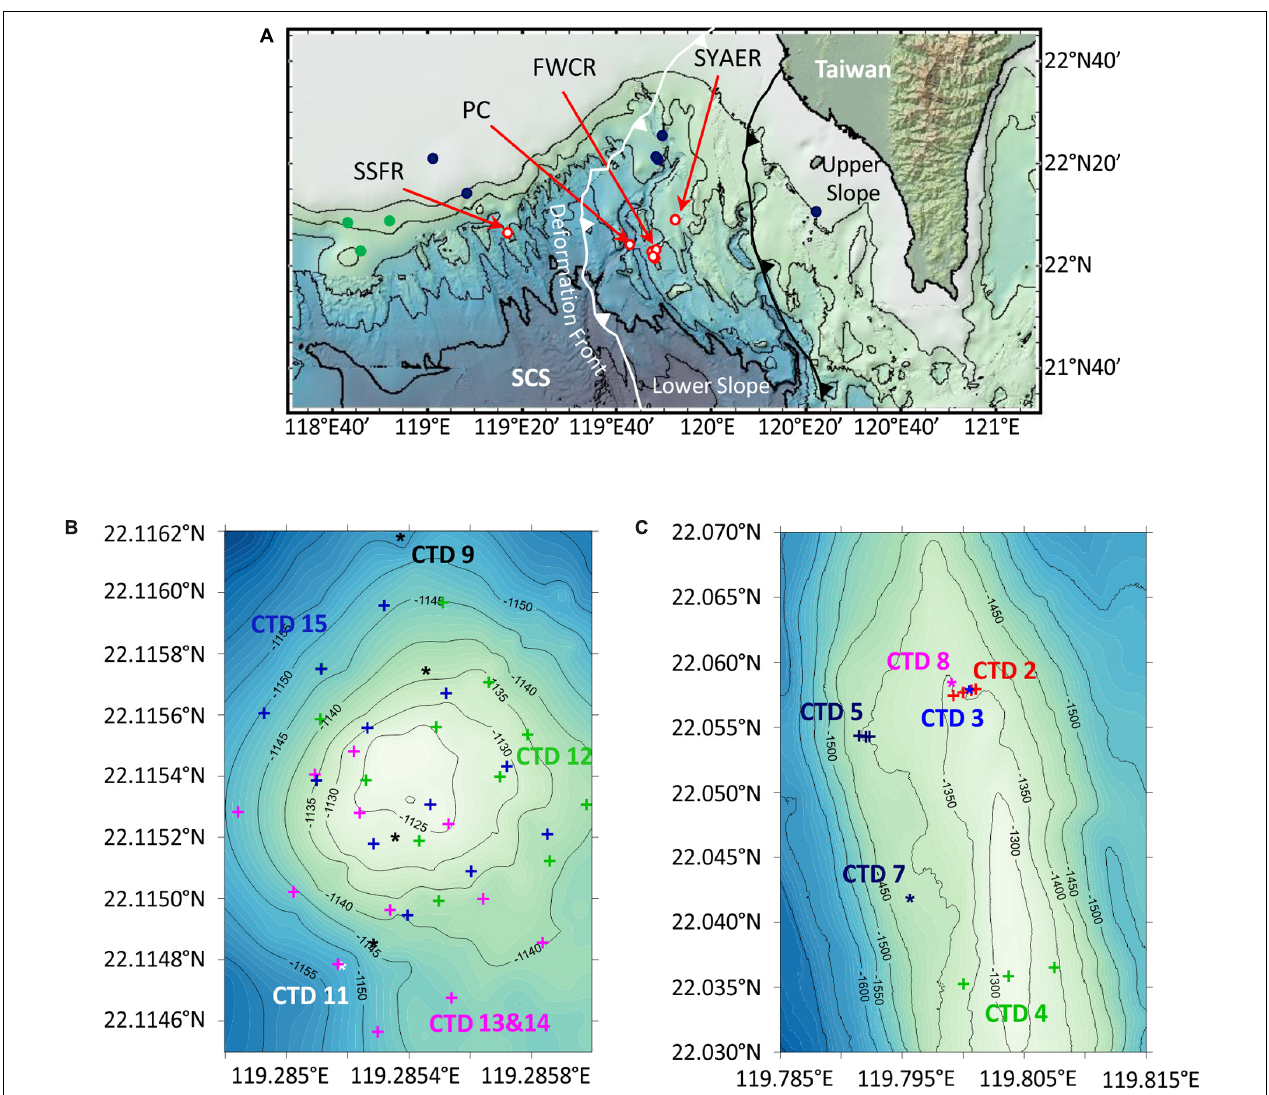
FIGURE 1 | Maps of research areas SW of Taiwan. (A) Overview map of the northern South China Sea (SCS) including water column sampling stations at Southern Summit Formosa Ridge (SSFR), Penyu Canyon (PC), Four Way Closure Ridge (FWCR), and South Yun An East Ridge (SYAER), which are all shown as red circles. Stations, where the water column was sampled for methane concentration analyses by Yang et al. (2006) are displayed as dark blue dots, and stations where authigenic carbonates were observed by Han et al. (2008) are shown as green dots. The deformation front (white line) and the upper and lower slope boundary (black line) are adopted from Lin et al. (2009). (B,C) Bathymetric maps of SSFR and FWCR that include locations of CTD-hydrocasts.